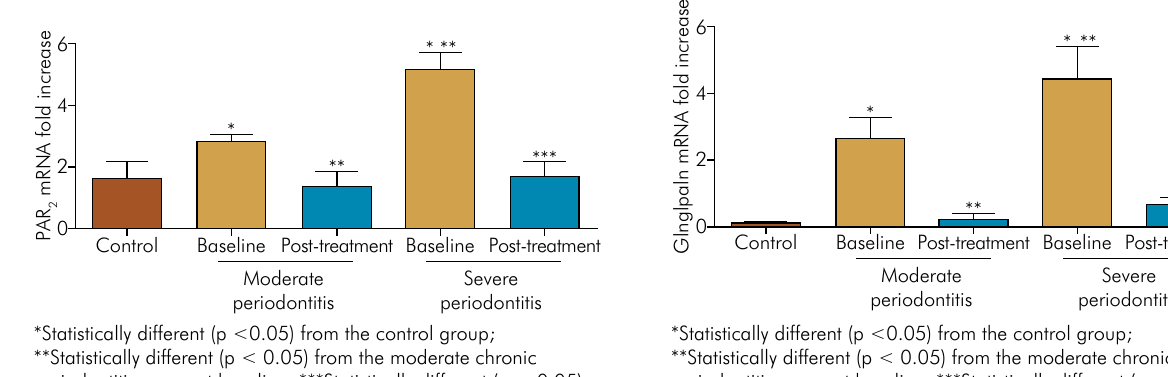
Figure 1. Mean and standard deviation of PAR-2 mRNA in the GCF of the control group and groups with chronic periodontitis at baseline and after non-surgical periodontal therapy.